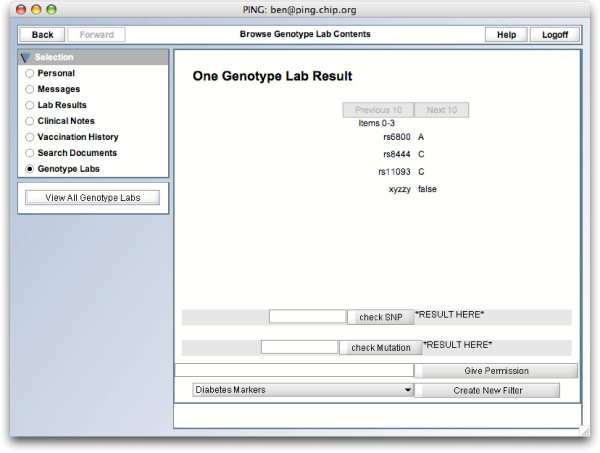
GenePING health care provider filtered view. A doctor viewing a patient's records. Note how only one document shows up, and no information is available as to whether that document is filtered or not. Comparison with the patient's view reveals that it is indeed a filtered document, but a doctor would not learn this from his view on the data.